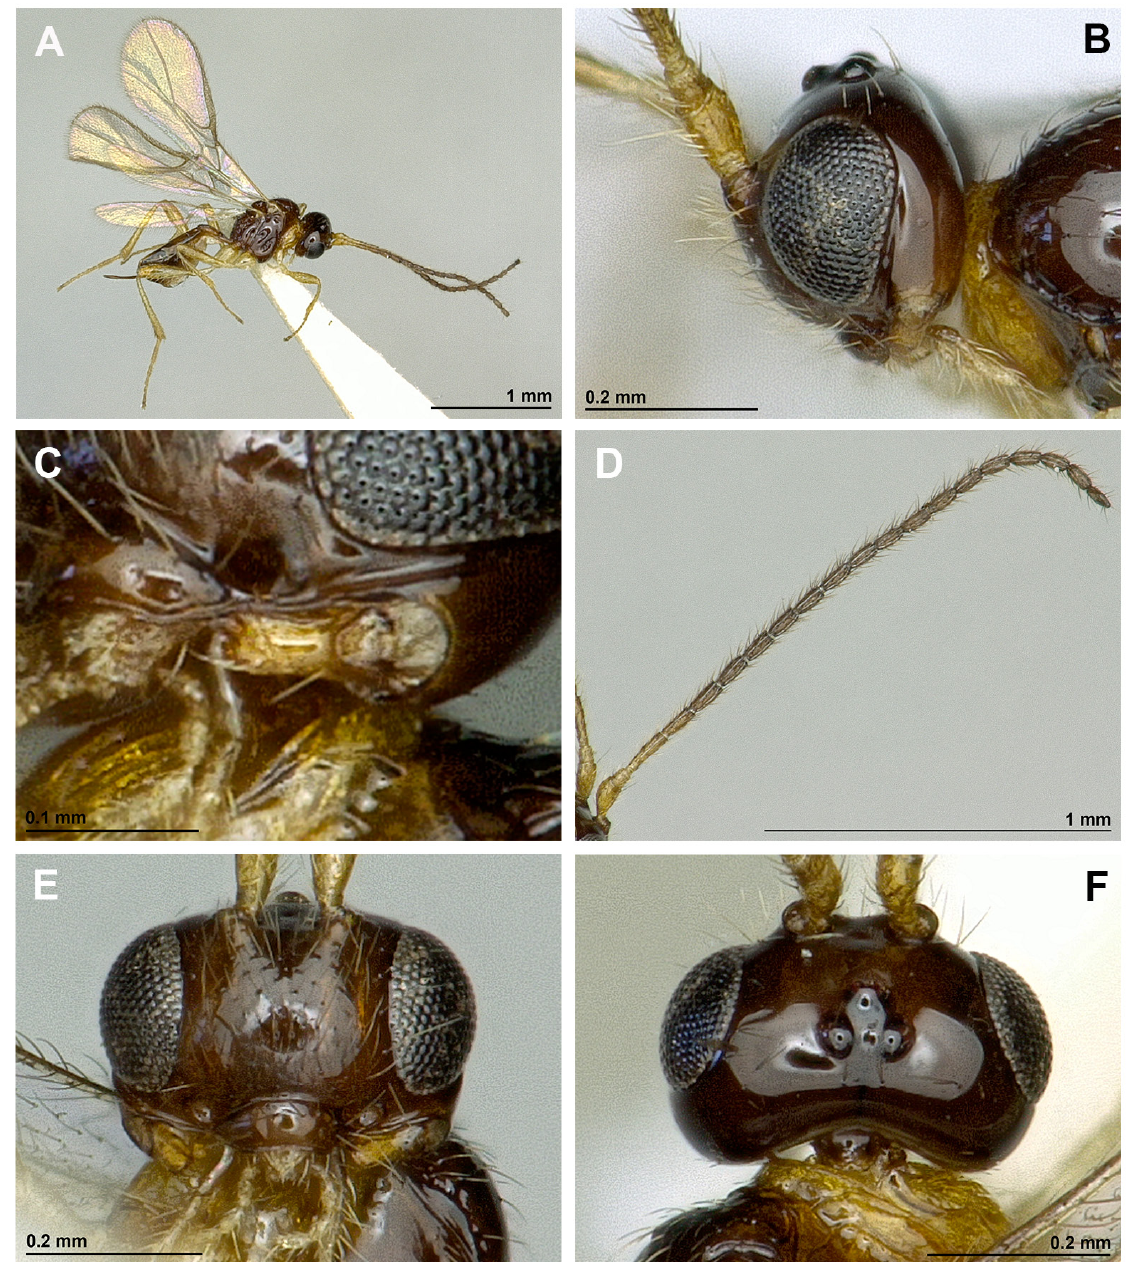
Fig. 8. Synaldis magnioculis Peris-Felipo, sp. nov., ♀. A . Habitus, lateral view. B . Head, lateral view. C . Mandible. D . Antenna. E . Face, front view. F . Head, dorsal